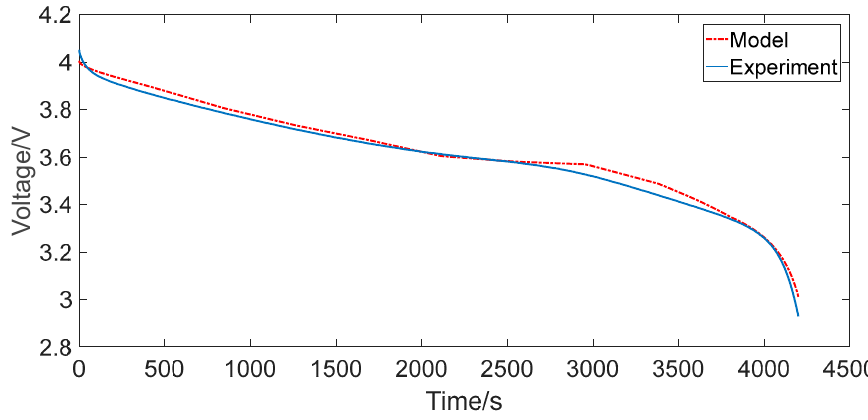
Figure 11. The simulation output of the first-order RC model for 1C constant current discharging.